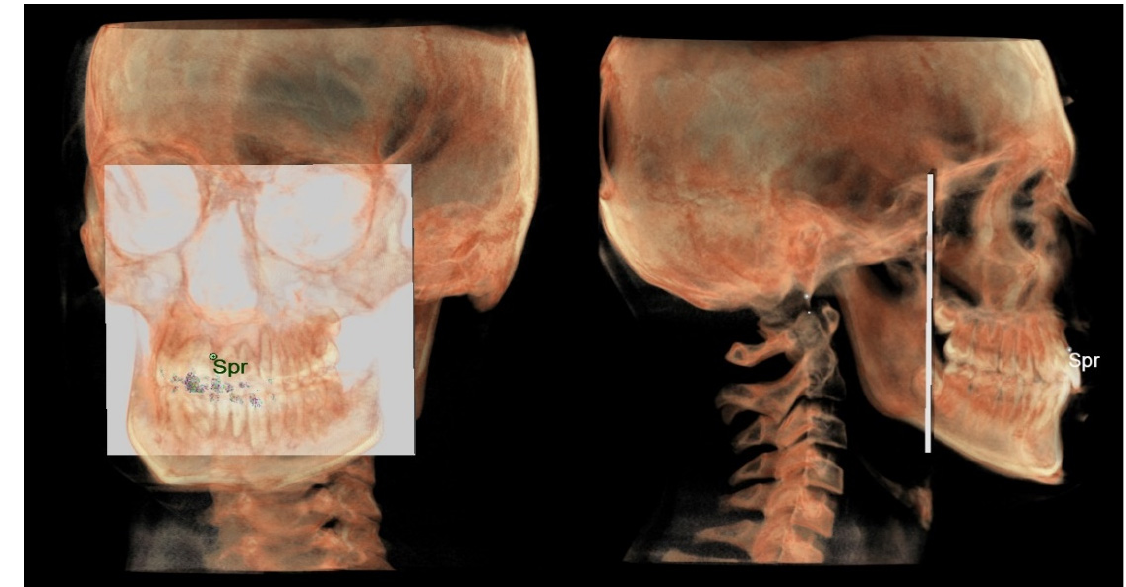
Figure 8. Maxillary dento-alveolar arch in 3D analysis.